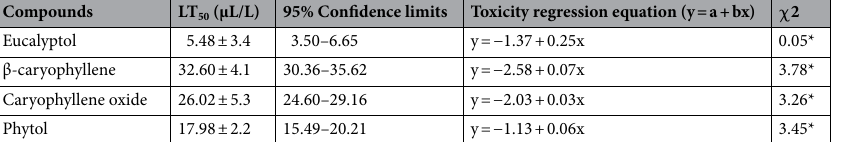
Table 7. Fumigation toxicity of the four individual compounds mostly found from the seven essential oils of Ar. argyi in China against the female adults of An. sinensis . *Significant at p < 0.05 level.